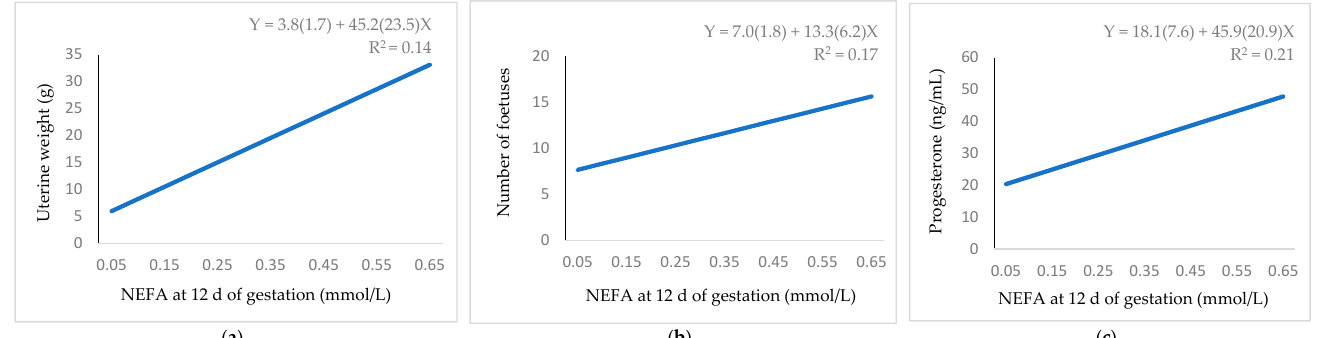
Figure 5. Regression equation (standard error between brackets) at 12 d of gestation for the relationship between NEFA and: ( a ) uterine weight; ( b ) number of foetuses; ( c ) progesterone.